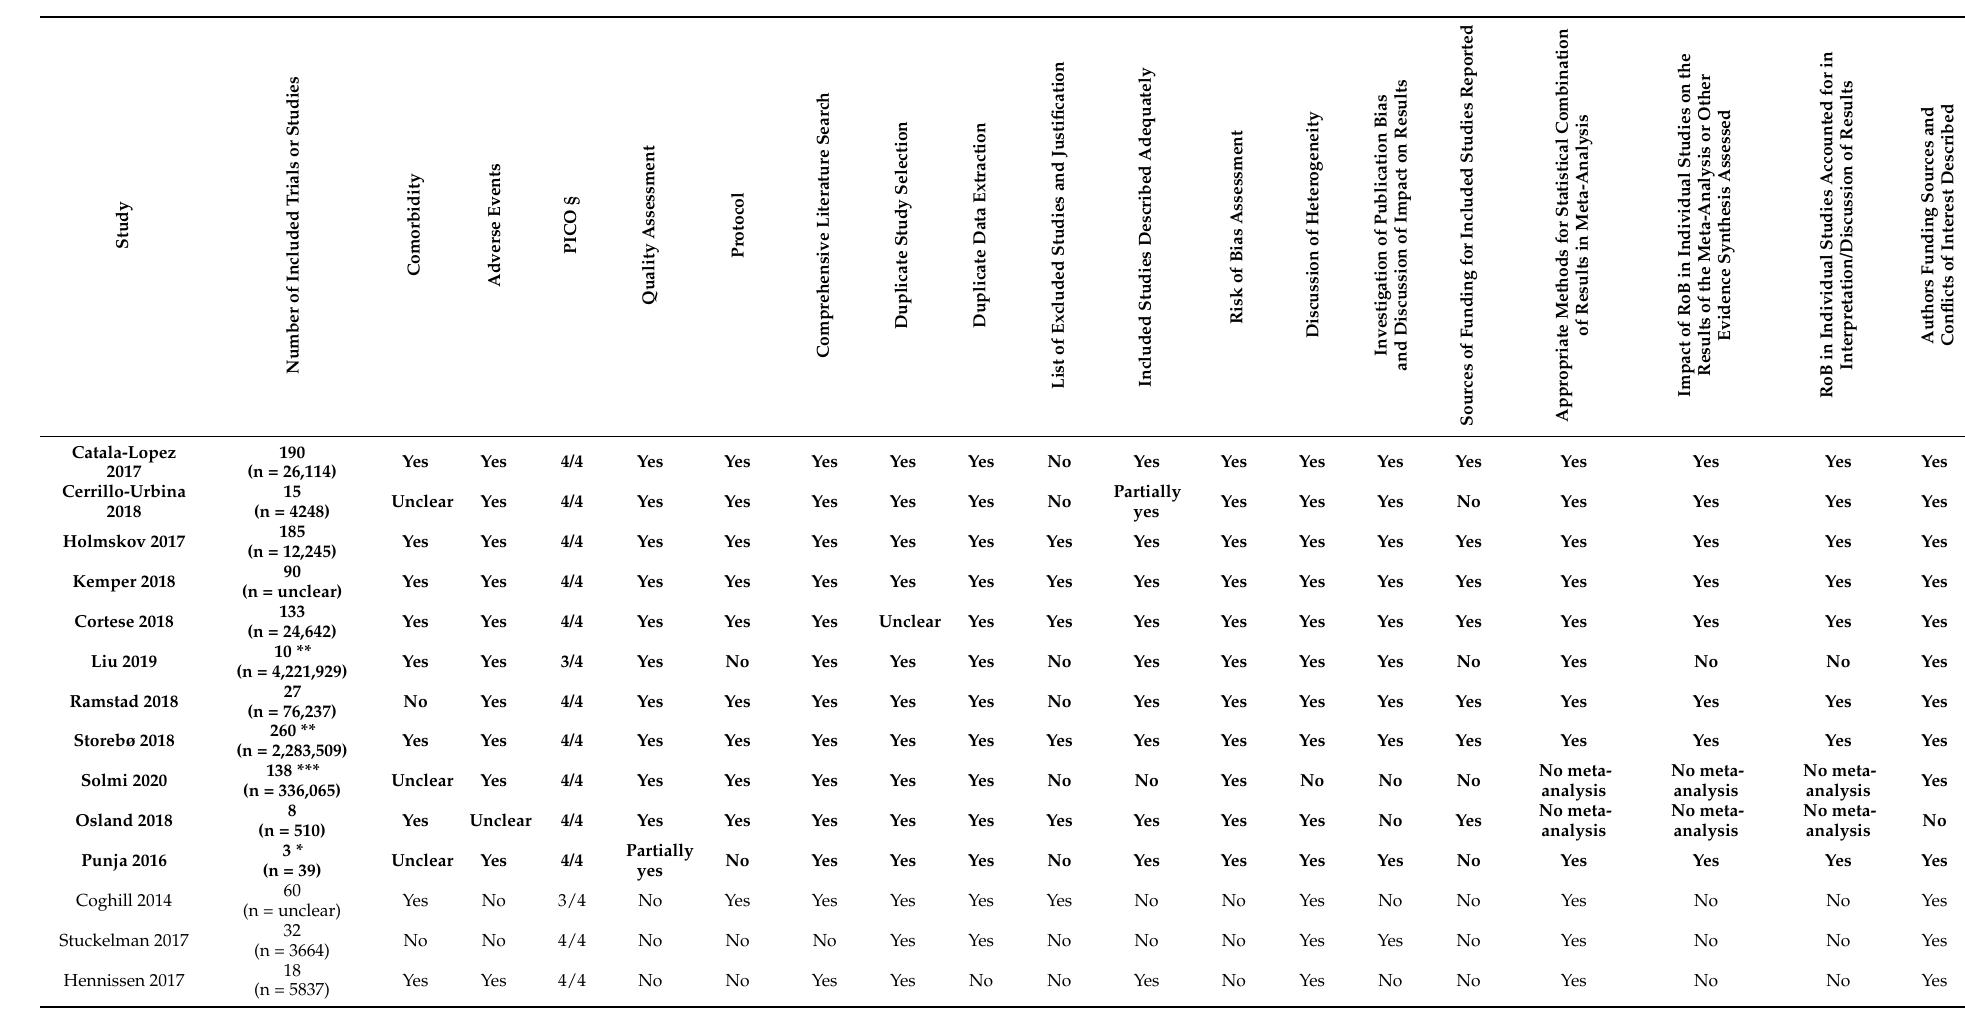
Table 1. Quality assessment of included